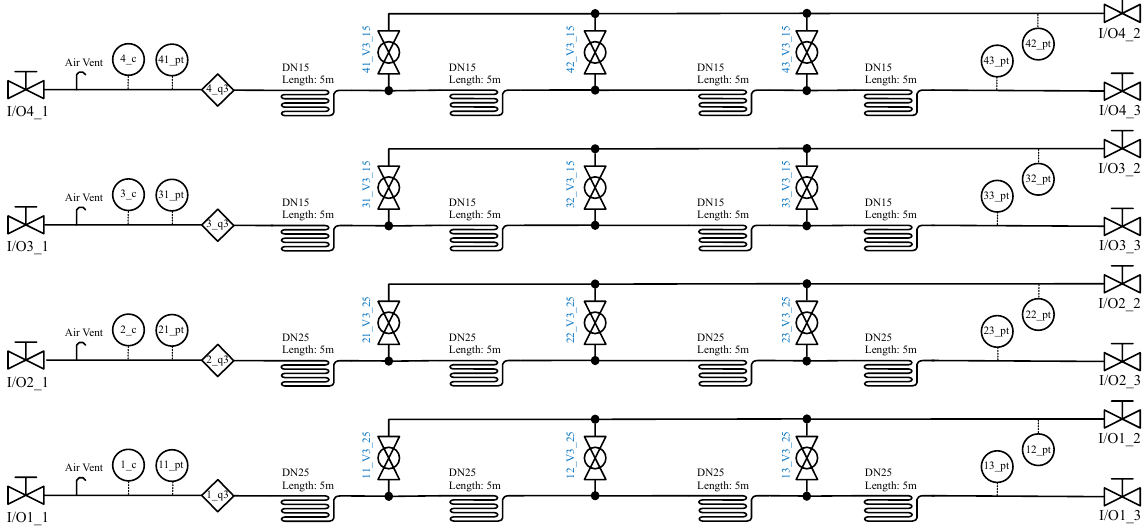
Figure A5. Piping and instrumentation diagram of the pressurised pipe unit. . The legend is shown in Figure A1 and the details for each component are listed in Table A1. Shut-off valves are locally controlled to block or bypass different hydraulic circuits, thus enabling different